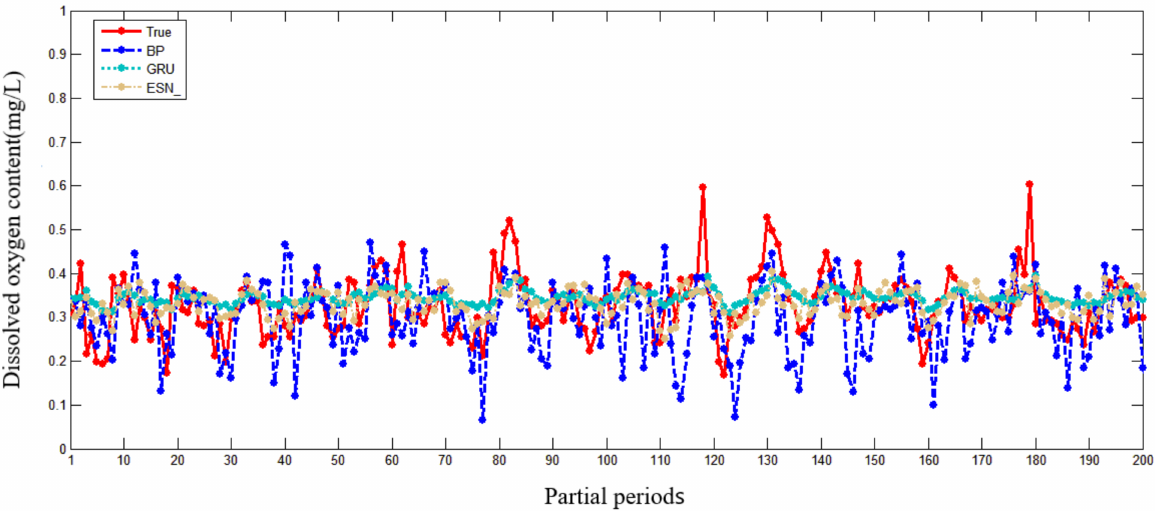
Figure 8. Partial prediction results of different prediction models in Oxtail Sea.